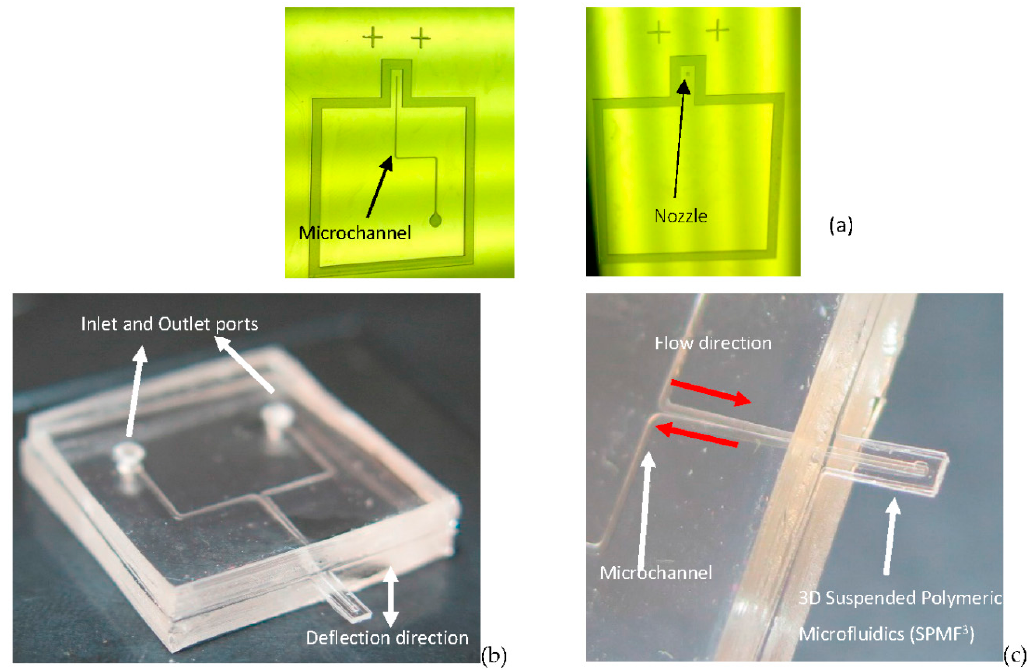
Figure 3. ( a ) Microchannel and nozzle molds for PDMS microfabrication, ( b ) Fabricated 3D suspended polymeric microfluidic system ( c ) Detailed view of the SPMF 3 .